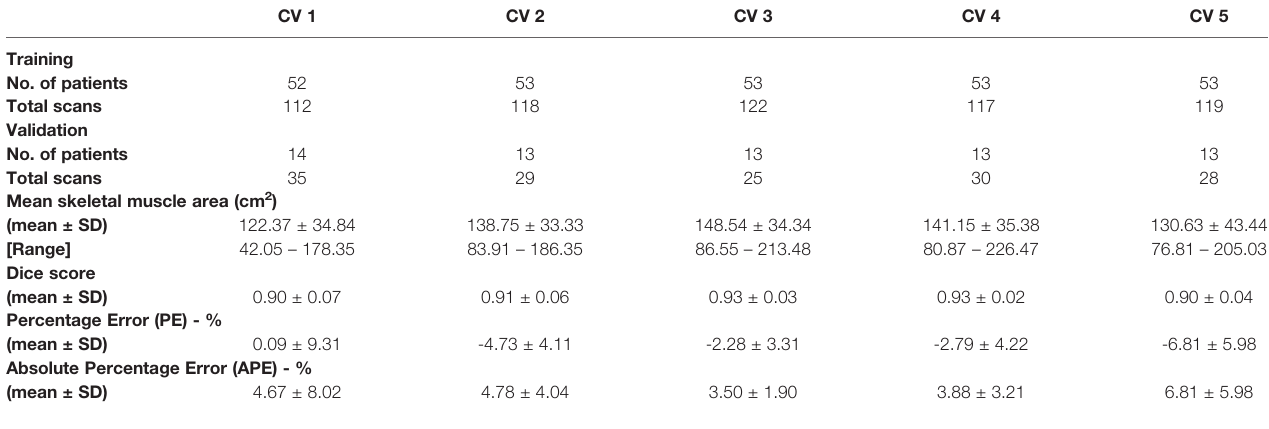
TABLE 2 | Validation results for cross validation (CV) in terms of mean and standard deviation (SD) of performance